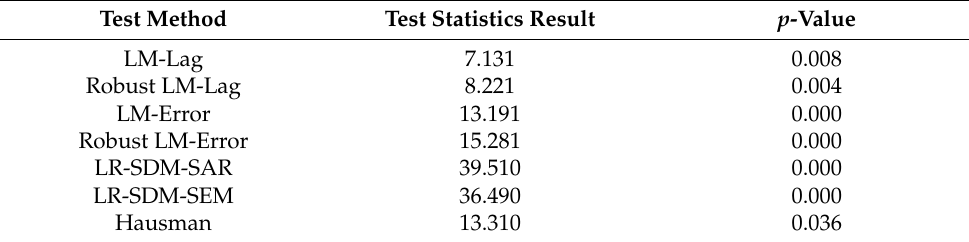
Table 3. Test results of model